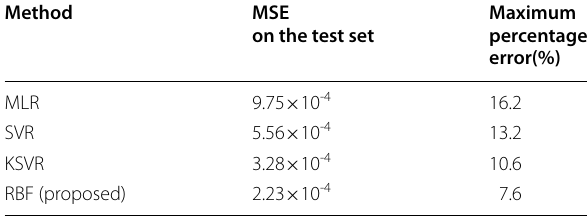
Table 6 Dimensionless crack depth calculating results obtained by different crack diagnosis methods on the test set Method